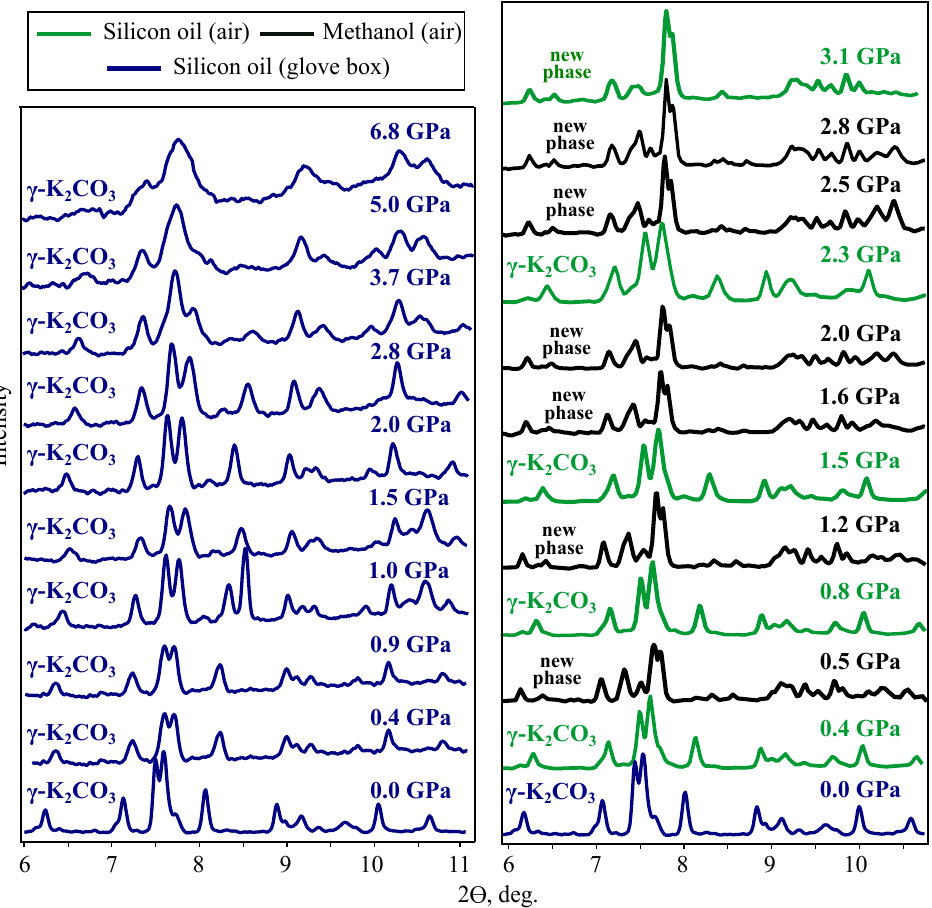
Figure 8. Diffraction patterns recorded in DAC-SSTRC experiments. Results of experiment ( I ) are shown in green, of experiment ( II ) in black and of experiment ( III ) in